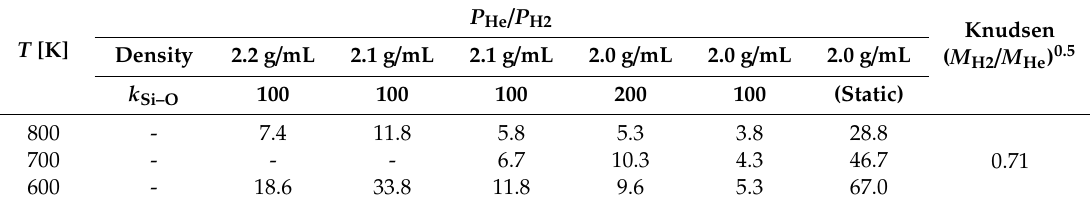
Figure 3. Temperature dependency of gas permeability for virtual silica membrane models of ( a ) 2.0 g / mL, ( b ) 2.1 g / mL, and ( c ) 2.2 g / mL. Table 3. Permeability ratio, P He / P H2 , for virtual silica membrane models.